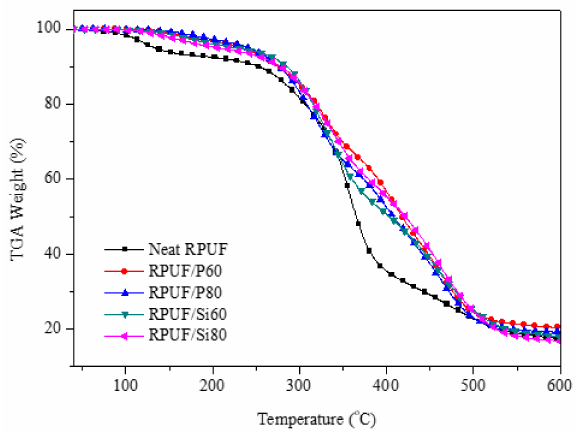
Figure 7. TG curves for